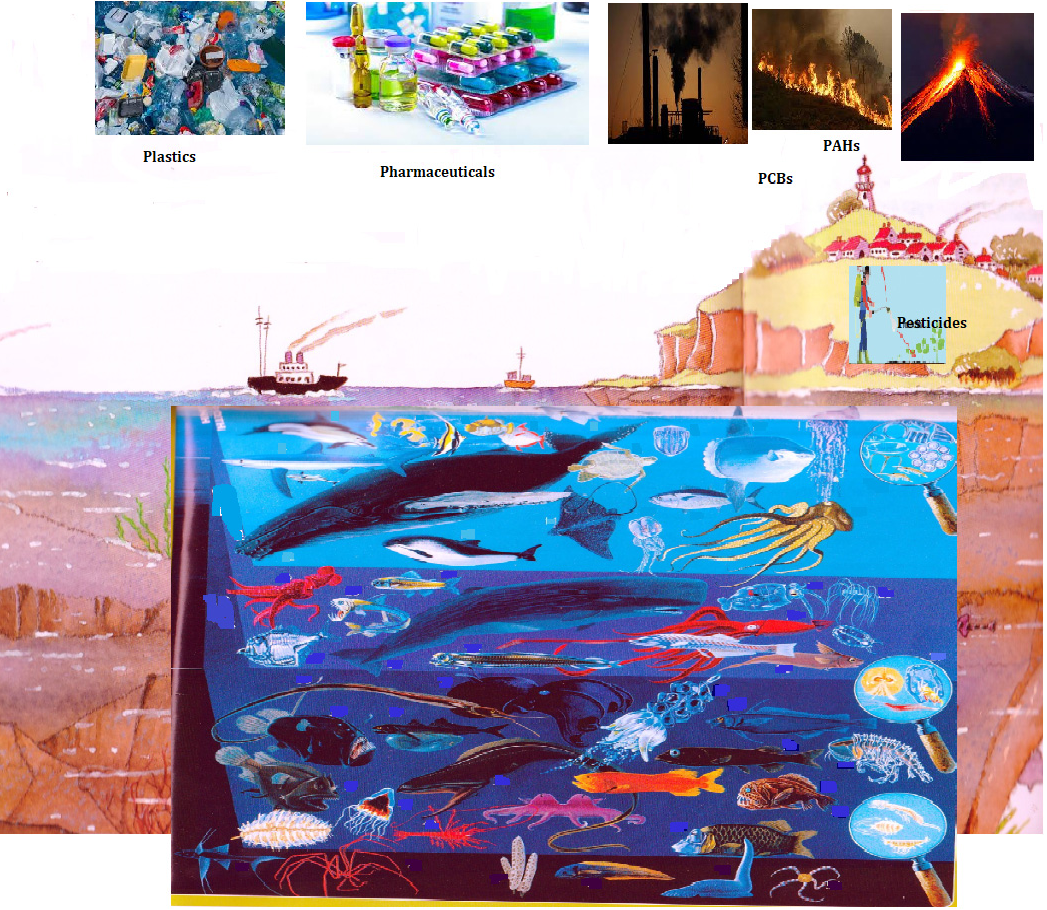
Figure 1. Sources and pathways for selected/studied categories of POPs into the marine environment.